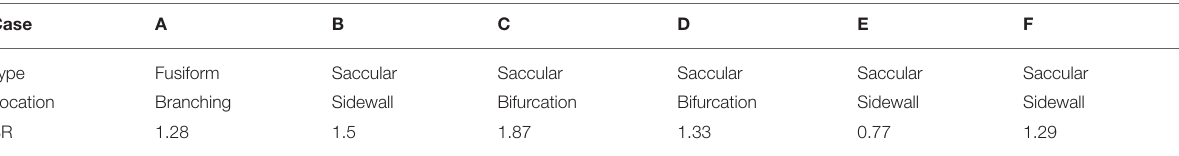
the simulations are not performed with patient-specific